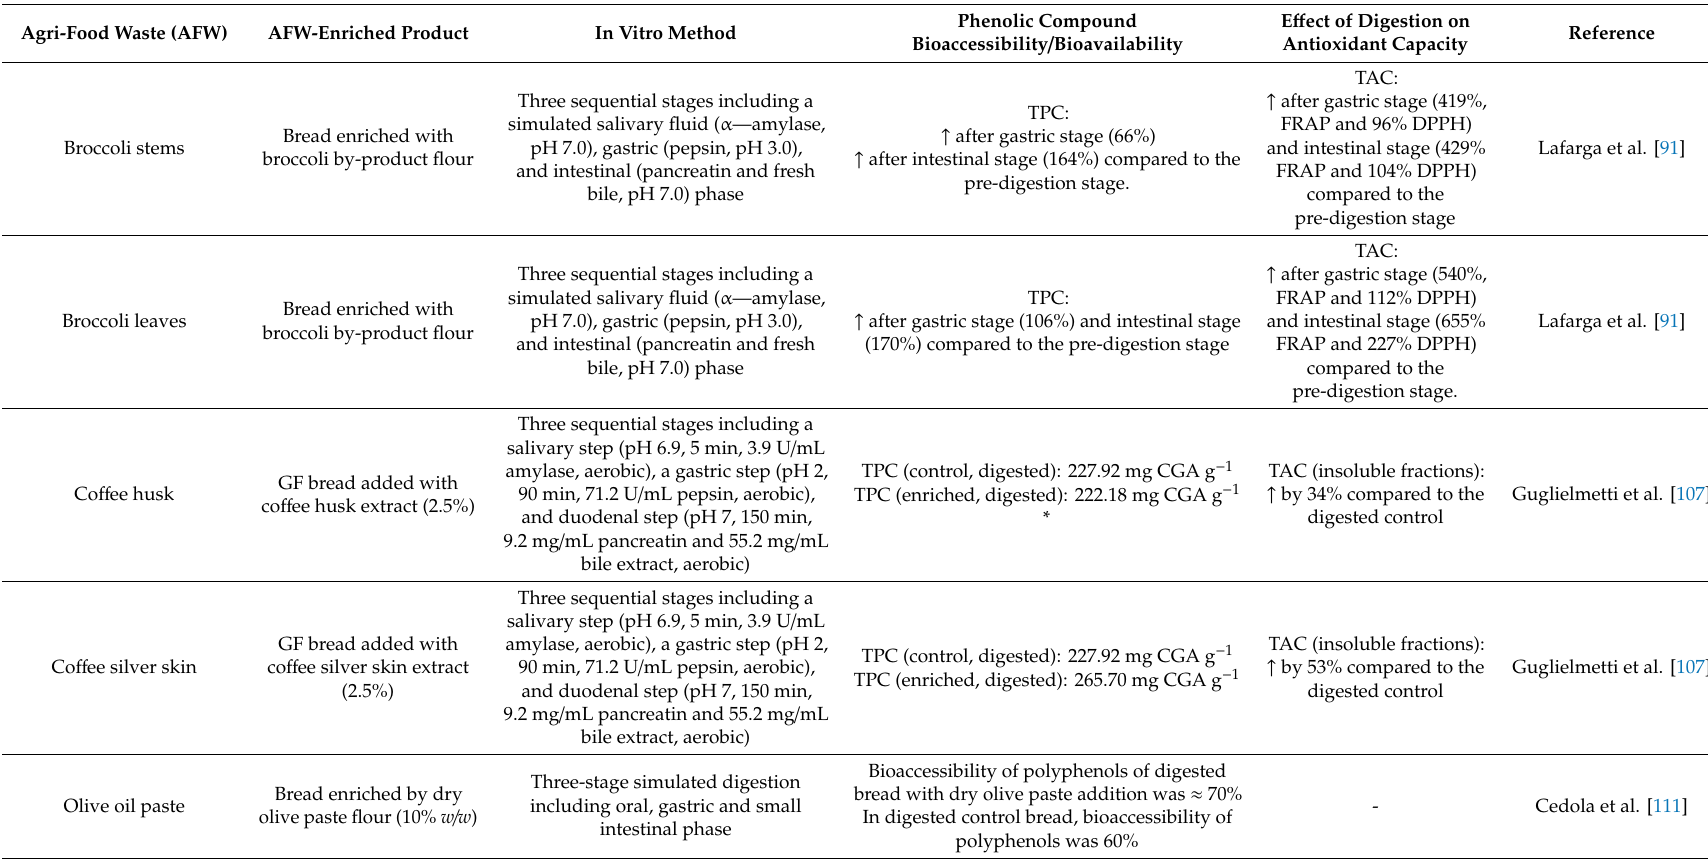
Table 3. Studies on phenolic compounds bioaccessibility and bioavailability in bakery products added with agri-food